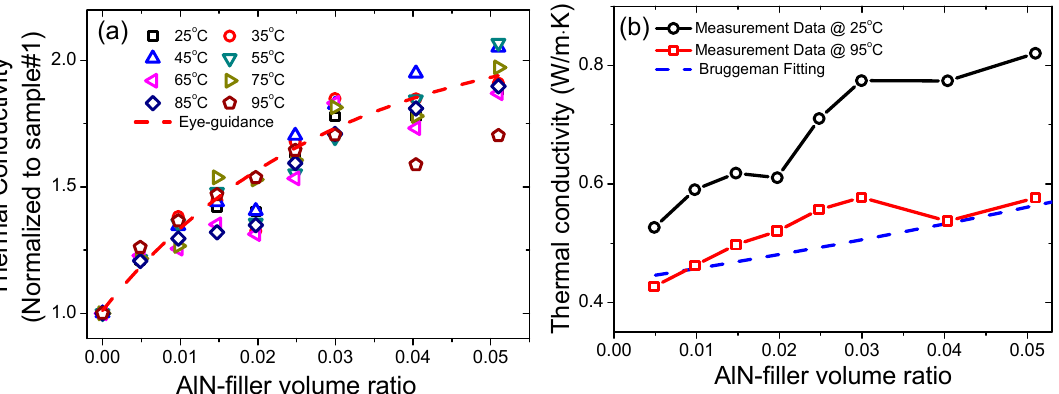
Figure 10. ( a ) Thermal conductivity data normalized to that of the sample #1, ( b ) Bruggeman fitting for the thermal conductivity data.